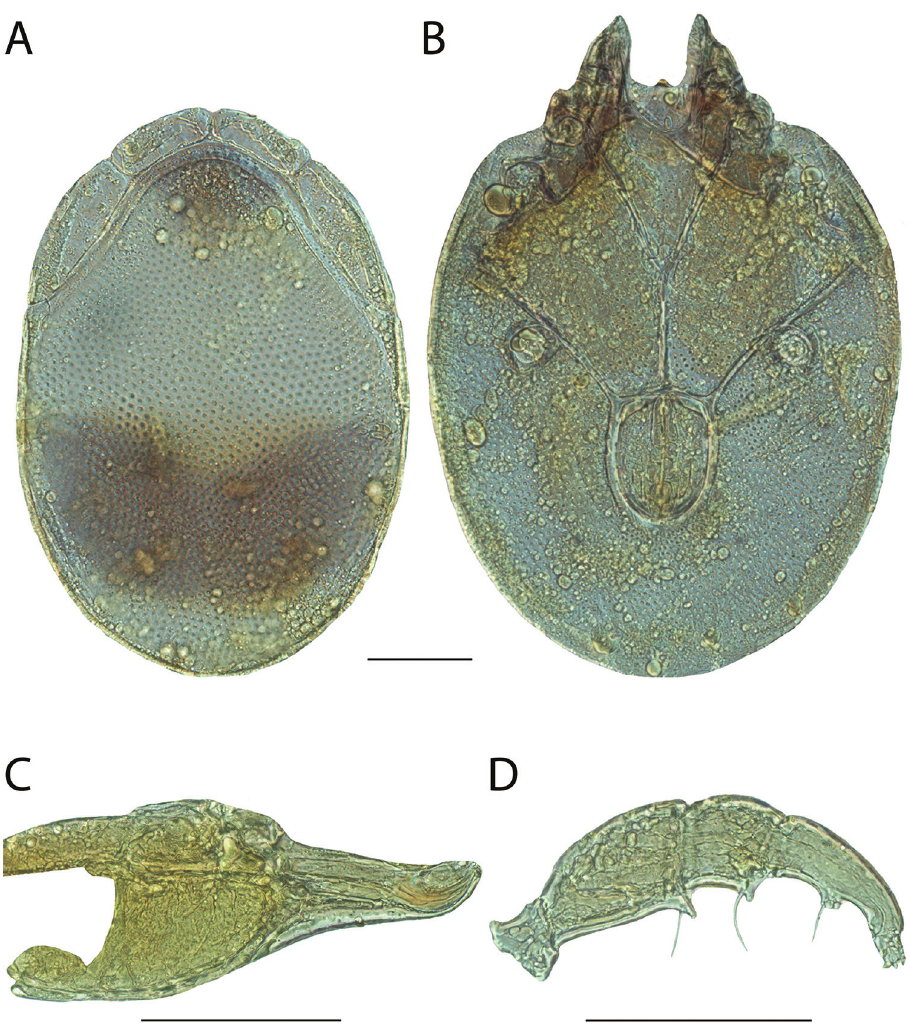
Figure 116. Torrenticola kittatinniana male: A dorsal plates B venter (legs removed) C subcapitulum D pedipalp (setae not accurately depicted). Scale = 100